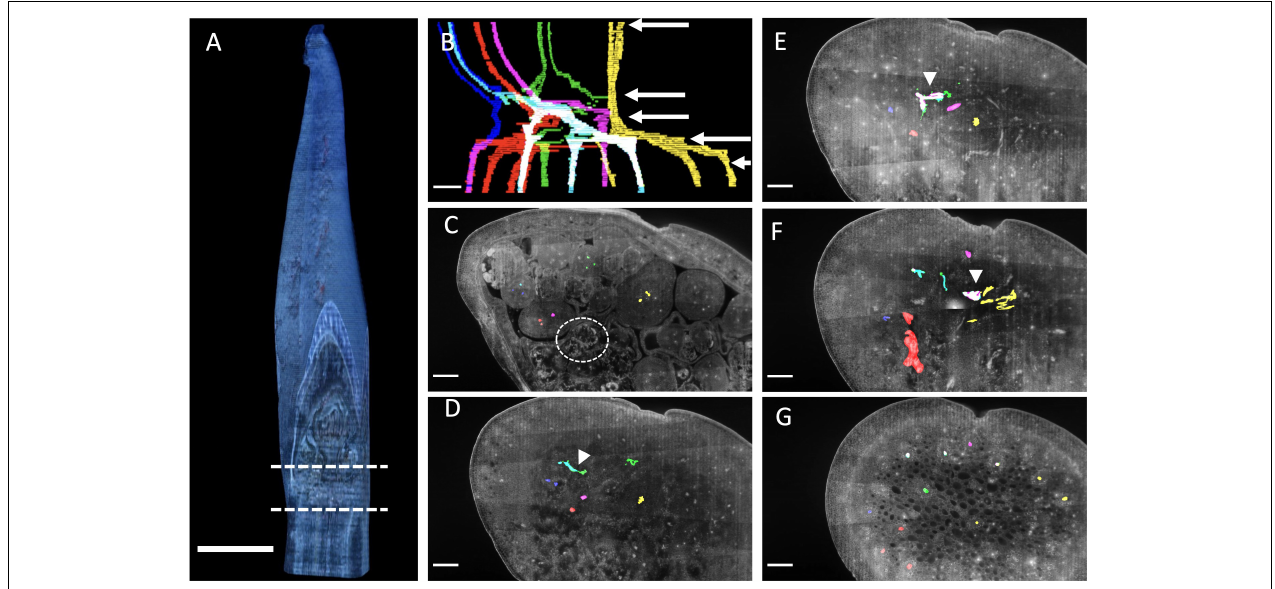
FIGURE 11 | Butomus umbellatus inflorescence anatomy. (A) Inflorescence reconstructed from serial sections at 15 µ m increments. Region in between dashed lines correspond to the section of vasculature in (B) . (B) Outlined vascular bundles in the absence of other tissue. Colors correspond to different flowers (1) yellow, (2) red and magenta, (3) green, (4) blue and cyan. White arrow corresponds to the individual section, in descending order, shown in the following panels. (C–G) Individual anatomical panels, in grayscale. Circle indicates meristematic tissue. White arrowheads indicate when vascular bundles from distinct flower pedicels merge. Scale bar of all images: 500 µ m.